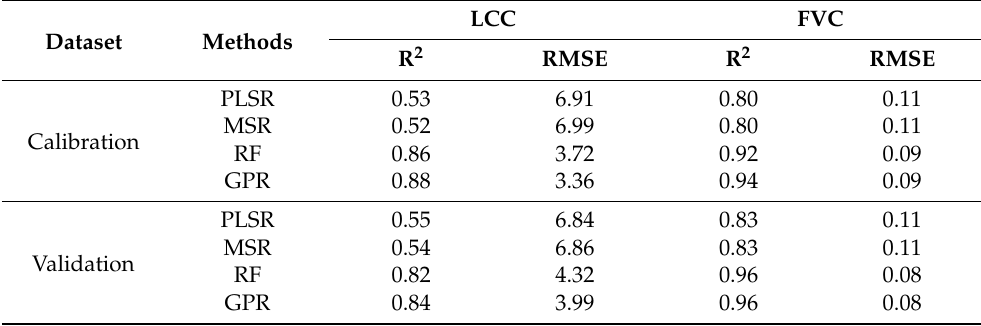
Table 5. LCC and FVC estimation results.